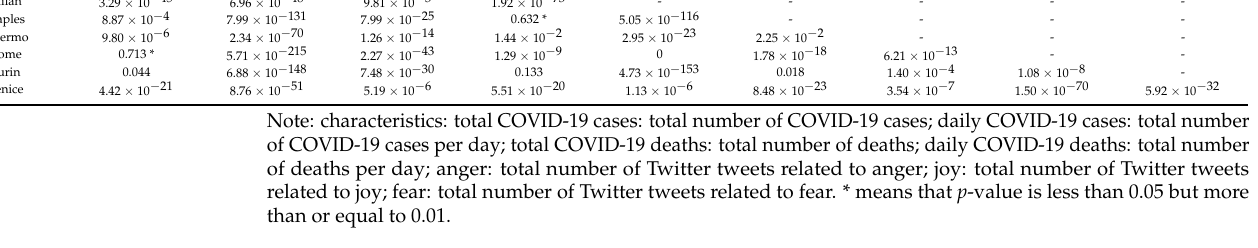
Table 6. Joy t-statistics